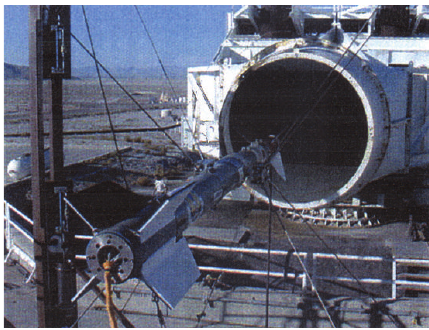
Figure 12: HiVAS/BOA test configuration [91].